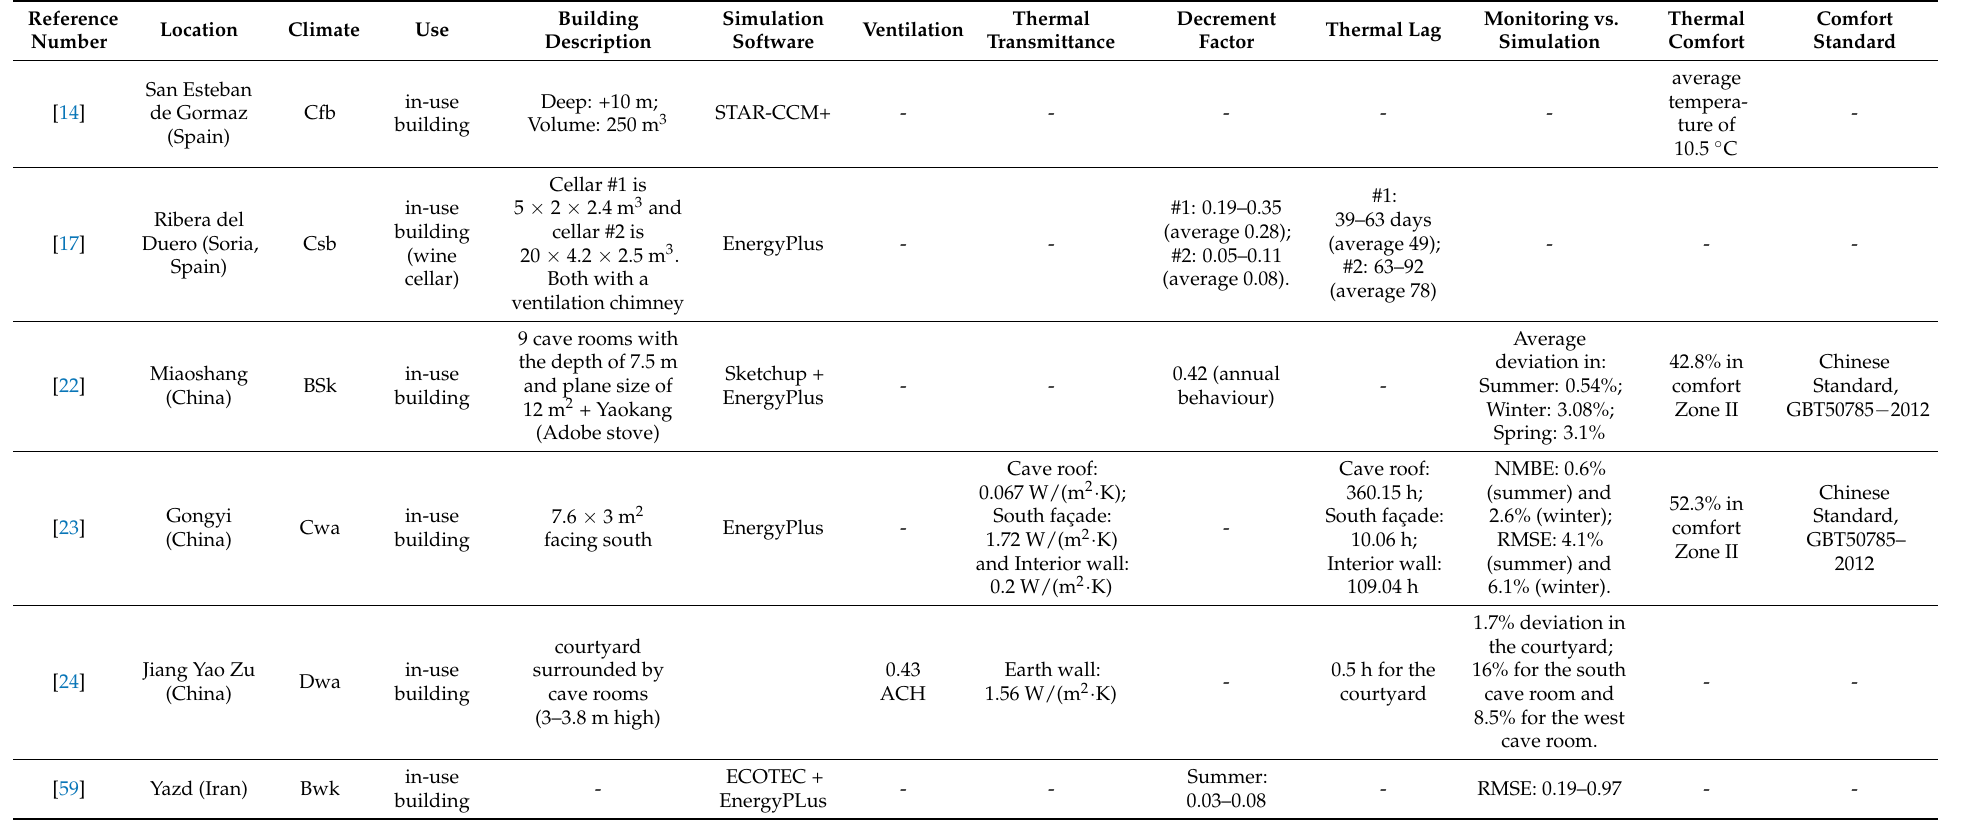
Table 3. Building characteristics and thermal performance of the earth dug out simulated studies.